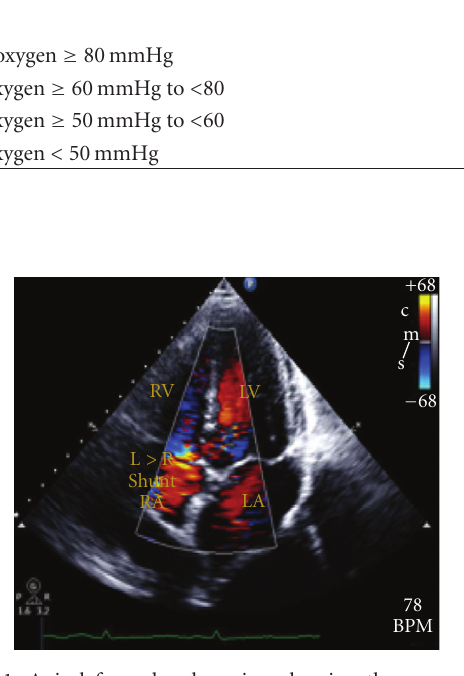
Figure 1: Apical four chamber view showing the presence of a patent foramen ovale with predominant left-to-right